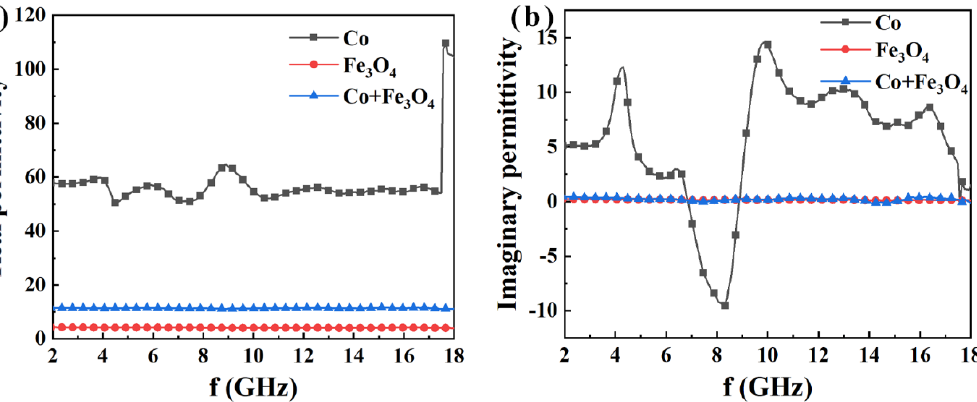
Figure 6. ( a ) Real ( ε ′ ) and ( b ) imaginary ( ε ″ ) parts of the permittivity curves for Co, Fe 3 O 4 , and Co/Fe 3 O 4 .